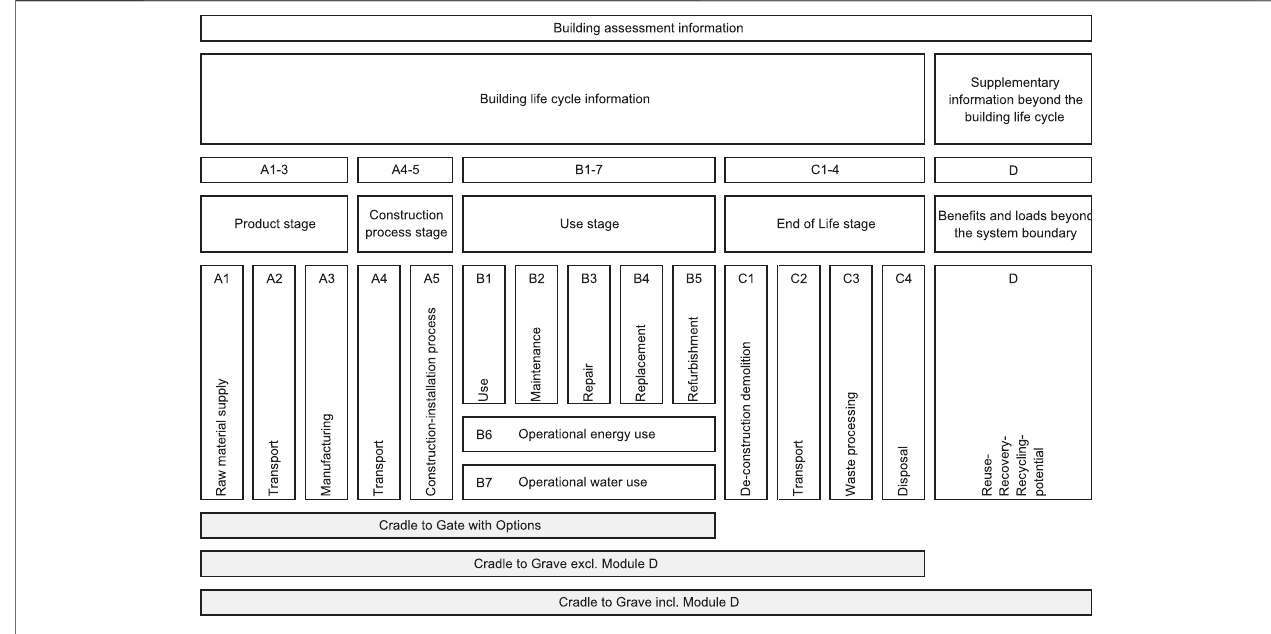
FIGURE 1 | Modules in building life cycle assessments according to EN 15978.